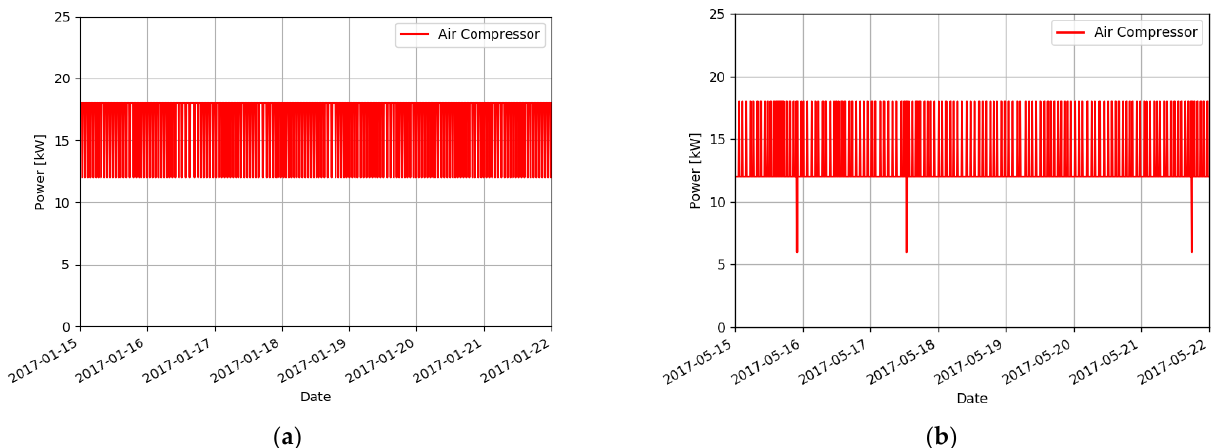
Figure 5. Raw Power data for the Air Compressor, ( a ) Training Period, ( b ) Test Period.